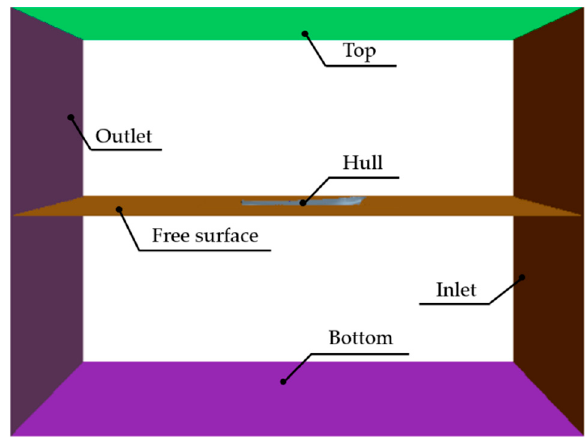
Figure 8. Boundaries representation of the simulation domain. Table 4. Boundary conditions and solver settings .